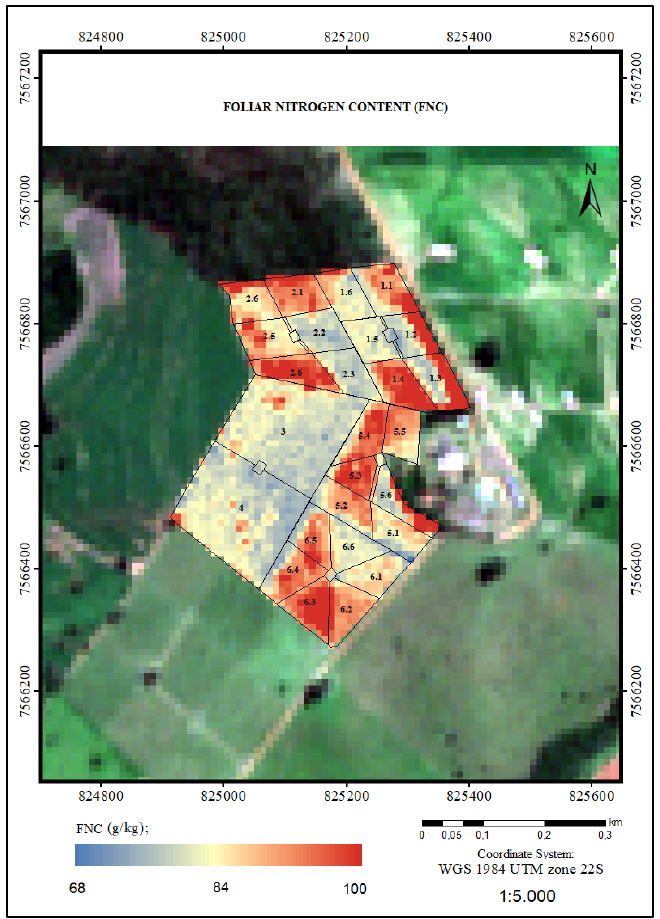
Figure 8. FNC (g kg −1 ) map with 10 m spatial resolution, estimated from Equation 1 applied on the Sentinel−2 image of April 25, 2018, over Piatã and Decumbens grassland area.